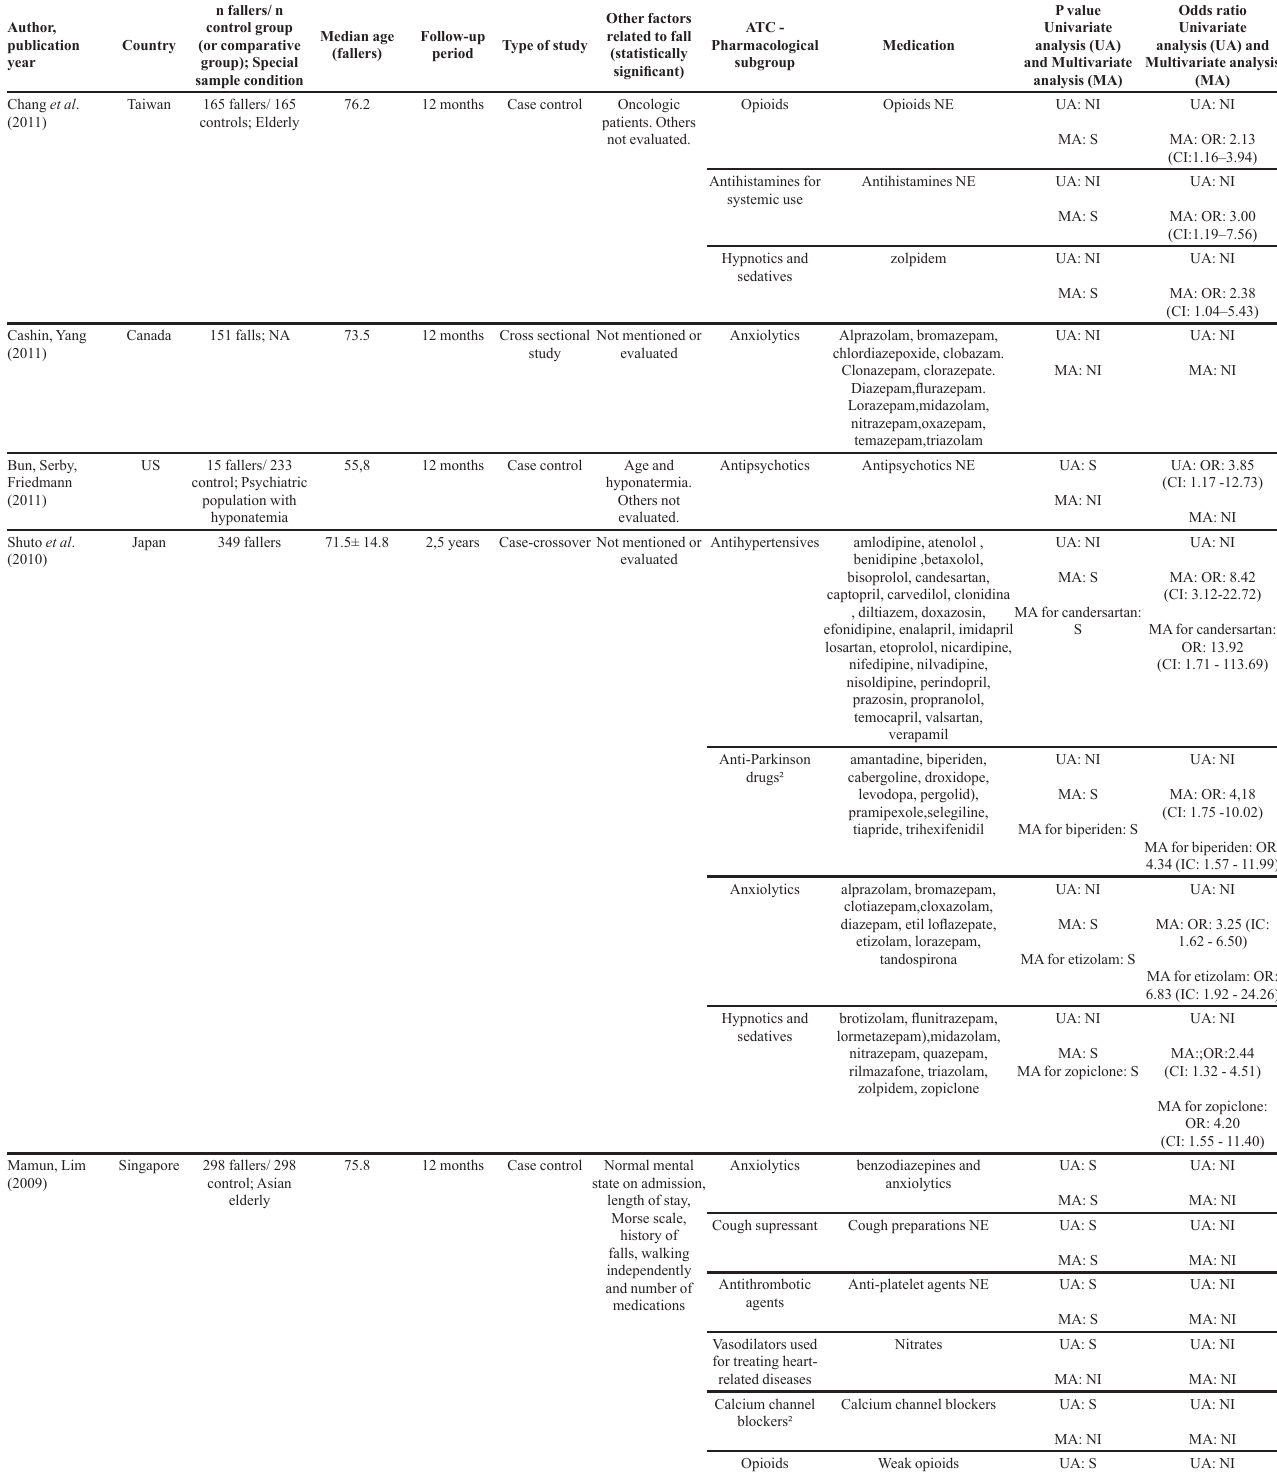
Follow-up period Type of study 76.2 Oncologic